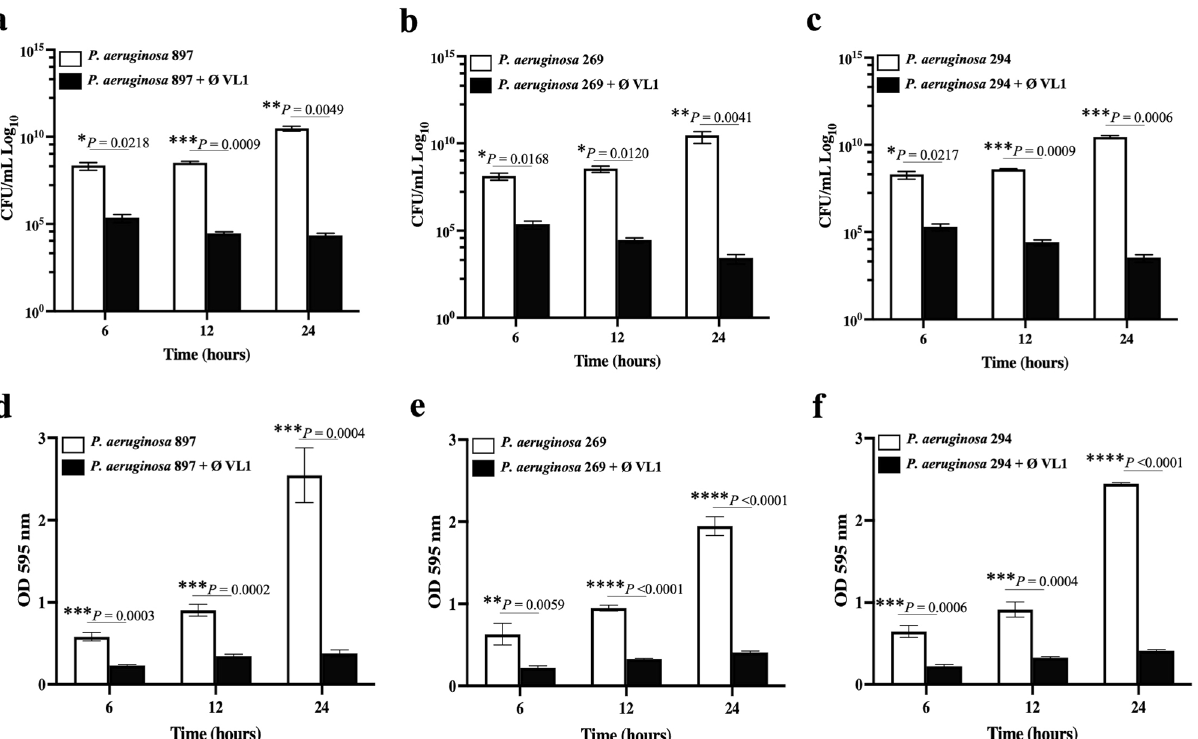
Figure 6. Biofilm eradication activity of the phage vB_PaeS_VL1 against clinical isolates of MDR P. aeruginosa. The viable bacterial cell counts in 48 h-old biofilms of P. aeruginosa strains ( a ) MDR PA897, ( b ) MDR PA269 or ( c ) MDR PA294 after treatment with phage VL1 for 6, 12 and 24 h were measured using the standard plate count. The total biofilm mass of 48 h-old biofilms of P. aeruginosa strains ( d ) MDR PA897, ( e ) MDR PA269 or ( f ) MDR PA294 after treatment with phage VL1 for 6, 12 and 24 h. The absorbance of each well was measured at 595 nm after a crystal violet stain. Data are presented as mean ± SD of three independent experiments. **** P < 0.0001, *** P < 0.001, ** P < 0.01 or * P < 0.05, Students t test, indicates statistically significant differences between experimental and control